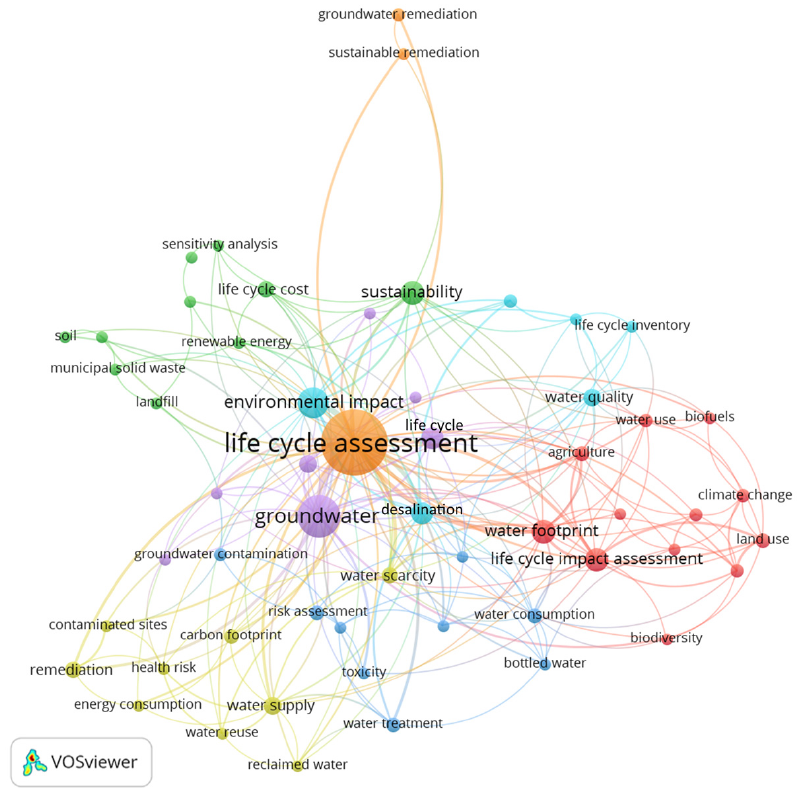
Figure 7. Author keywords network. Documents: 306 documents only from Scopus and 158 from WoS and 316 from both databases.